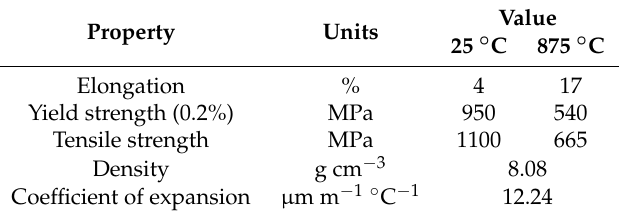
Table 1. Properties of Udimet R (cid:13) 720 alloy.